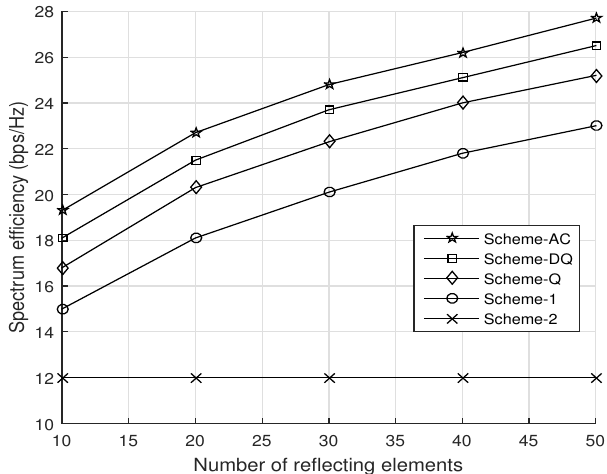
Figure 8. SE versus number of reflecting elements of